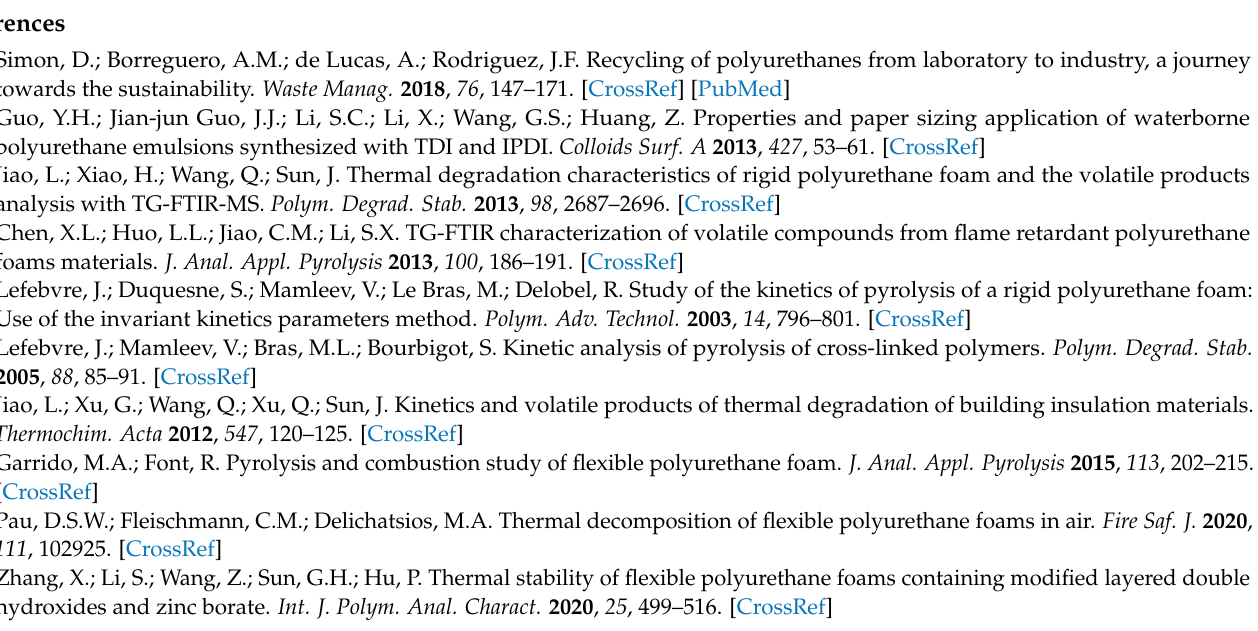
f( α ) for describing solid-state reactions; Table S2: Pyrolysis characteristic parameters for TSPU under different heating rates; Table S3: Pyrolysis characteristic parameters for WPU under different heating rates; Table S4: Activation energies estimated for pyrolysis of TSPU waste; Table S5: Activation energies estimated for pyrolysis of WPU waste; Table S6: Thermodynamic parameters estimated for pyrolysis of two polyurethanes; Figure S1: The AARD results for some reaction models via the CR method with the one global reaction model assumption for the entire pyrolysis of two PU samples; Figure S2: Simulated results obtained with the one global reaction model for pyrolysis processes of TSPU (a,b) and WPU